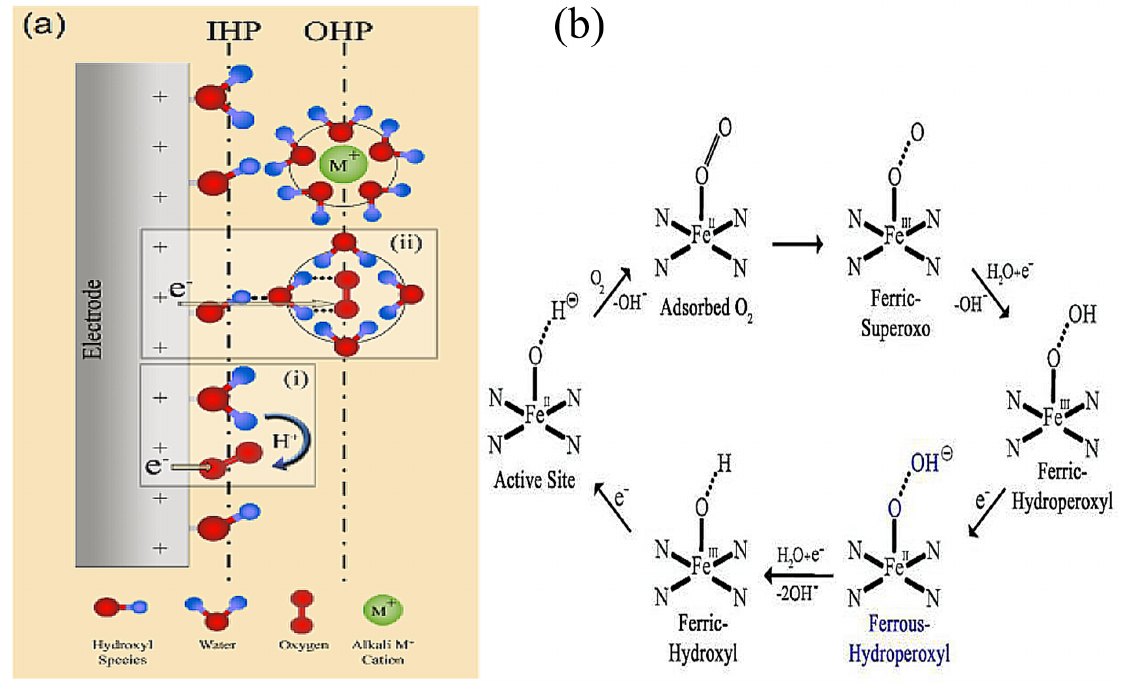
Figure 8. Proposed ORR mechanism. ( a ) Schematic illustration of inner-sphere (inset i) and outer-sphere (inset ii) electron transfer mechanisms during ORR in alkaline media. ( b ) Catalyst cycle showing the redox mechanism involved in ORR on pyrolyzed Fe–N 4 /C active sites in dilute alkaline medium; (IHP, inner Helmholtz plane; OHP, outer Helmholtz plane) (Reproduce with permission from Ref. [104]. Copyright © American